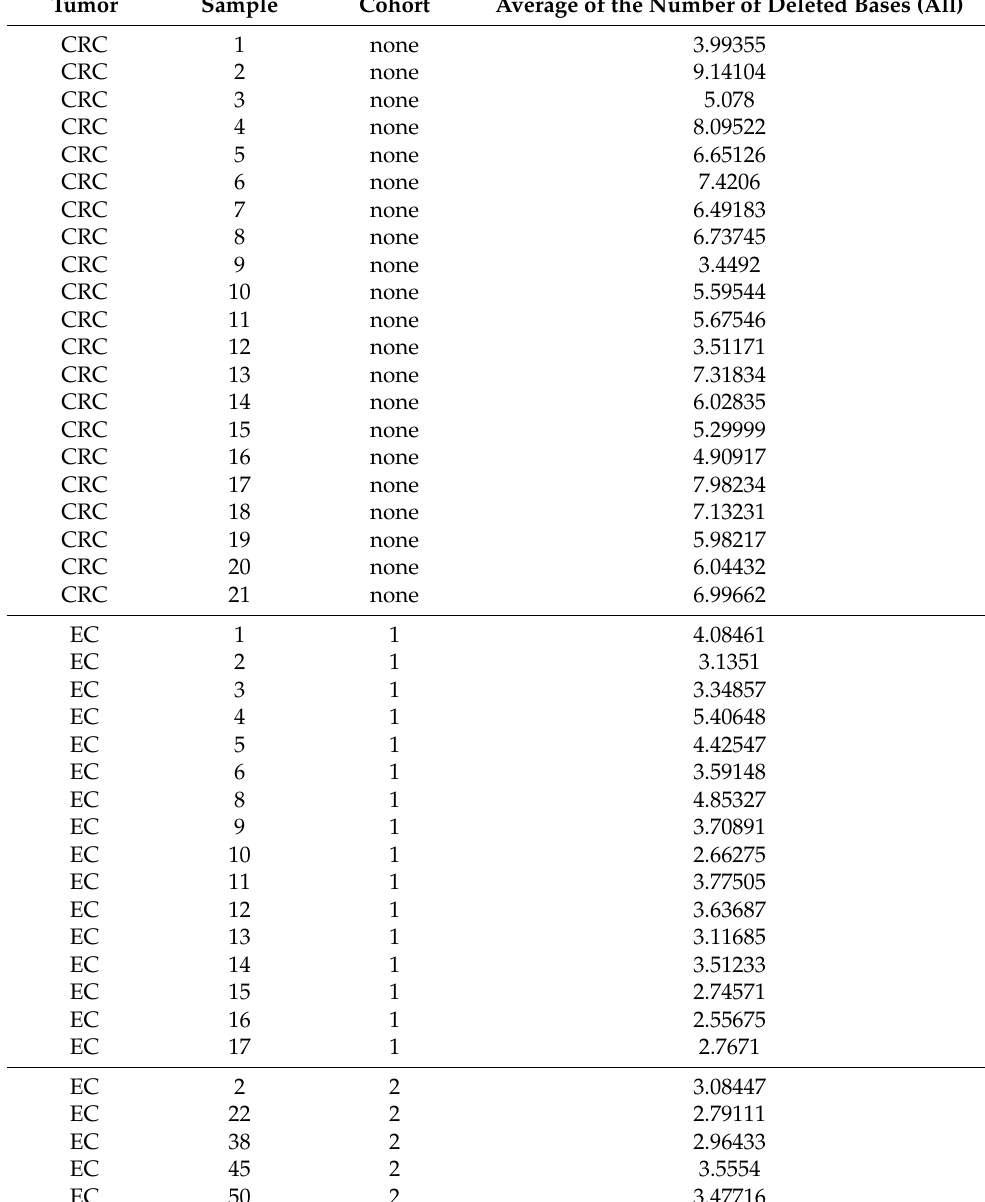
Table 2. Average of the number of deleted bases in 21 colorectal cancers (CRCs) and endometrial cancers (ECs) after next generation sequencing